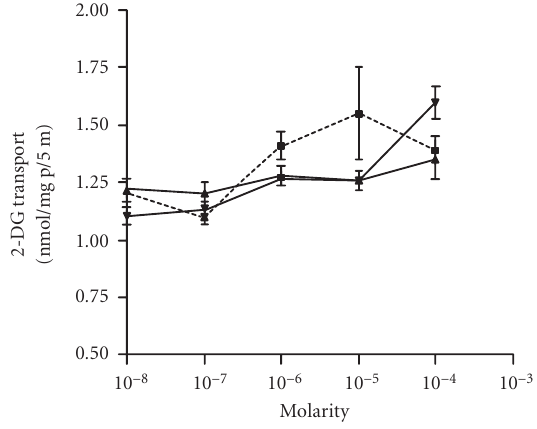
Figure 5. E ff ect of di ff erent vanadate compounds on 2-DG transport in L6 myoblasts. Sodium orthovanadate ( --- ), no significant di ff erences were seen. P > . 05, 1-way ANOVA, F = 1 . 33, n = 8 (triplicate plates in all exper- iments). pVA ( (cid:1) — (cid:1) ), ∗ P < . 05, 1-way ANOVA, F = 6 . 43, n = 6 (triplicate